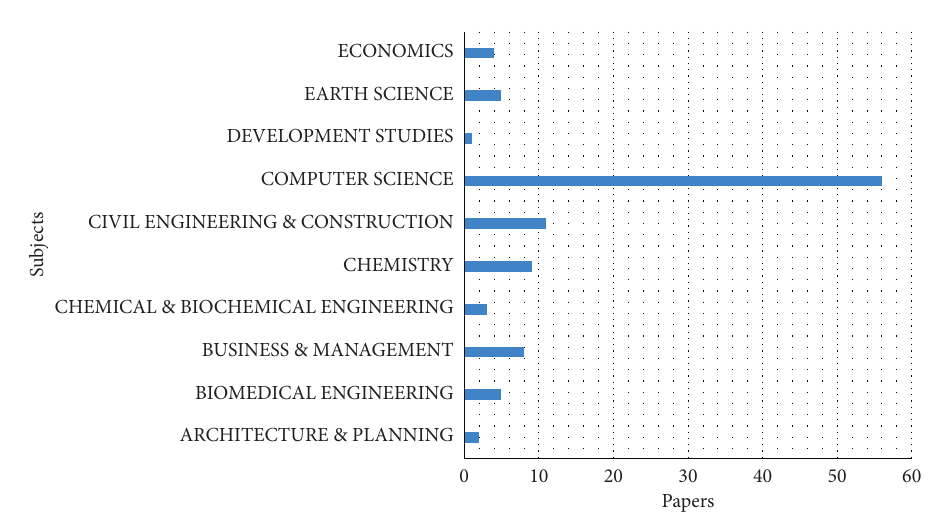
Figure 13: Paper type and papers.